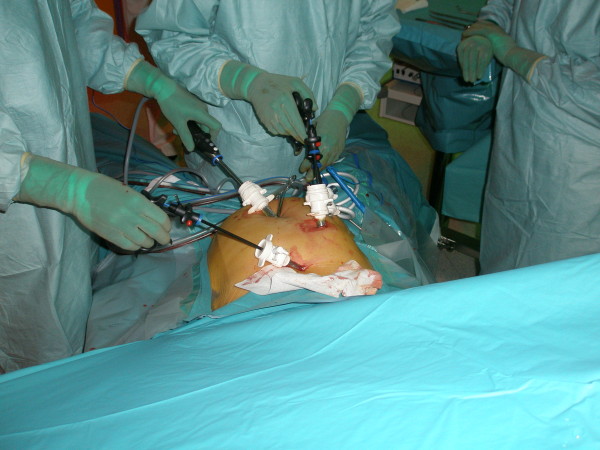
Laparoscopic procedure. Trocars are inserted in the abdomen (not from the presented case, picture kindly supplied by Dr. E. G. Hansen).